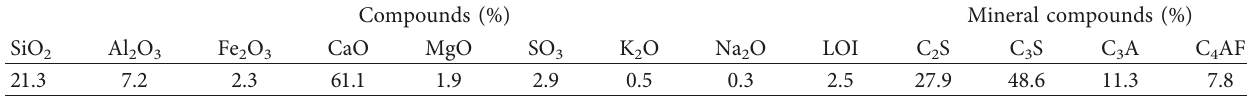
Table 1: Proportions of cement ingredients.